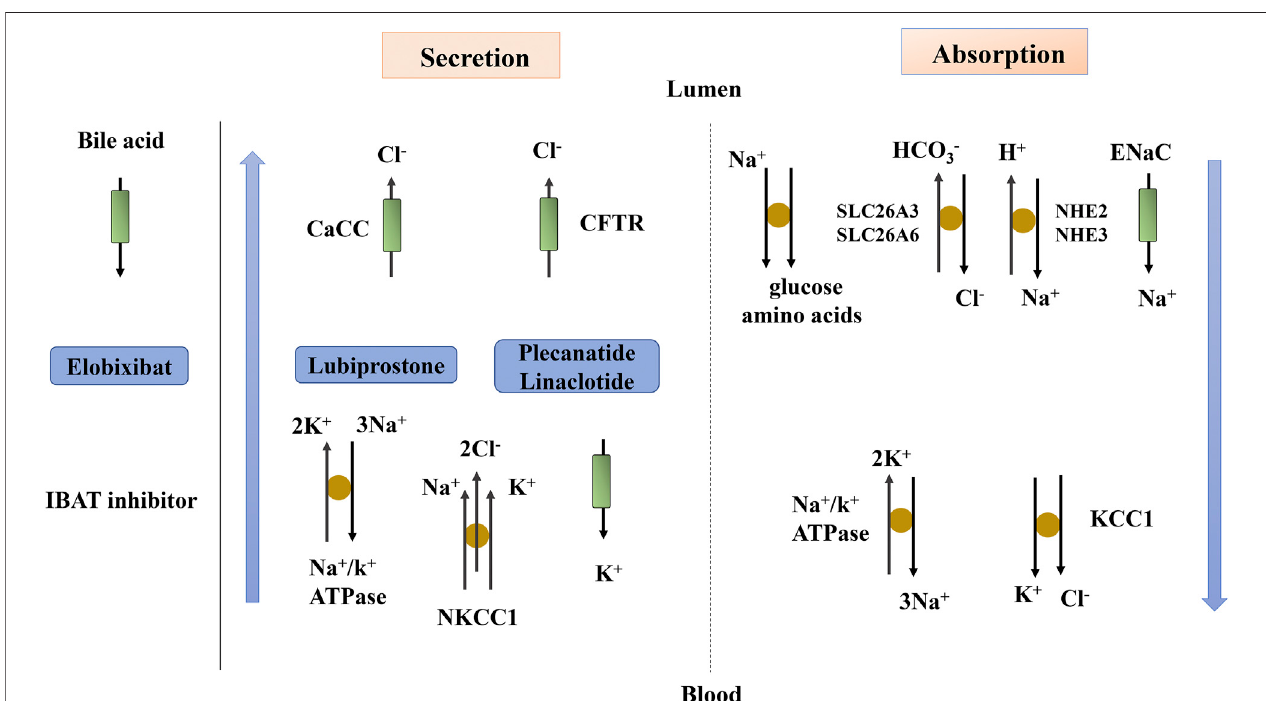
FIGURE3| Fluidandelectrolytetransportintheintestine.Thebluearrowindicatesthetransportof fl uidbesidethecells.Lubiprostone,PlecanatideandLinaclotide act through ion transport. CaCC, Ca 2+ -activated Cl − channel; CFTR, cystic fi brosis transmembrane conductance regulator; ENaC, epithelial sodium channel; IBAT, ileal bile acid transporter; KCC1, K + /Cl − co-transporter; NHE, Na + /H + exchanger; NKCC1, Na + /K + /Cl − co-transporter; SLC26A3, Cl − anion exchanger; SLC26A6, anion exchange